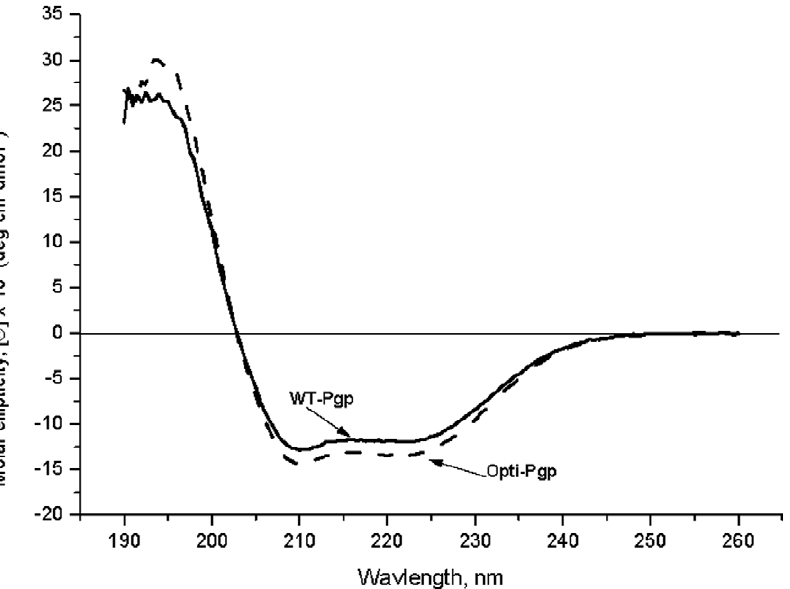
Figure 5. CD spectra of WT- and Opti-Pgp. CD spectra of the purified proteins were recorded after buffer exchange by size-exclusion chromatography (peak fractions from Fig. 3B). Protein concentrations were determined by UV spectroscopy, as well as the colorimetric BCA protein assay using BSA as a standard; the two assays gave essentially the same results. Each spectrum represents an average of 10 scan from three different protein preparations. Molar ellipticity values were calculated according to [ H ] = H (100 6 MRW/ lc ), where H is the measured ellipticity in degrees, MRW is the molecular weight of Pgp (141,000 g/mol), l is the path length in centimeters, and c is the concentration of the protein in grams per liter